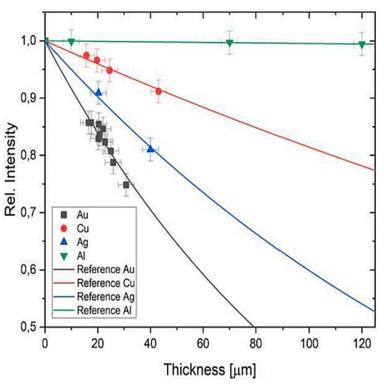
Relative intensity attenuation as a function of thickness for unknown ICs and mounted SMD components on single and double-sided PCBs. Data points and absorbance reference curves are color-coded for the materials Au (black), Cu (red), Ag (blue) and Al (green). The Material compositing are verified with EDX measurements.